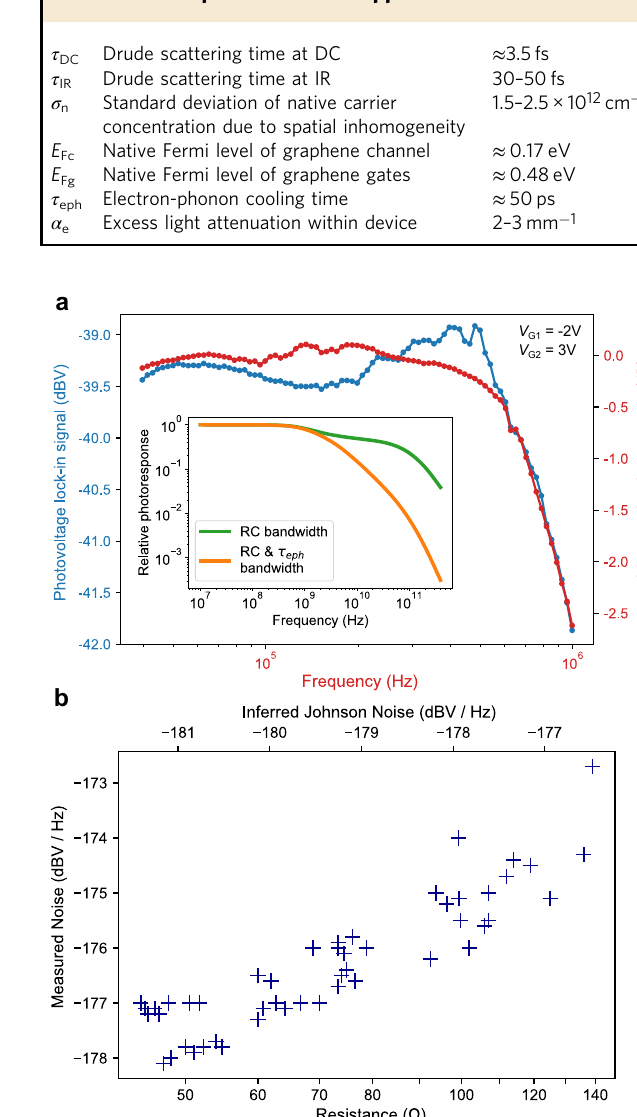
Fig. 4 Bandwidth and noise properties. a Comparison of the frequency response of our photodetector with that of the laser current modulation itself. The consistency between the two indicates that the photodetector frequency response exceeds 1 MHz. Inset: Simulated GHz-range photodetector frequency response, with and without considering the impact of the electron-phonon cooling time τ eph . b Measured noise spectral density versus resistance and corresponding Johnson noise spectral density of Device B, without illumination, for the 49 pairs of gate voltages { V g1 , V g2 } where each V gn is varied from − 6 V to 6 V in steps of 2 V. Measurement was performed at T = 293 Fig. 3 Experiment/model comparison. a , b Contour plots of the a measured and b modeled responsivity maps of our device, evaluated with τ DC = 3.5fs, τ = 40fs, σ = 2 × 10 12 cm − 2 , τ = 50ps, and α = 2.5 mm − 1 . c Electron IR n eph e temperature increase Δ T el and absorbed optical power per area _ Q pro fi les in the graphene channel per guided optical power at gate voltages of { − 2.35 V, 0.35 V}, chosen to maximize the modeled photoresponse, and other parameters as above.